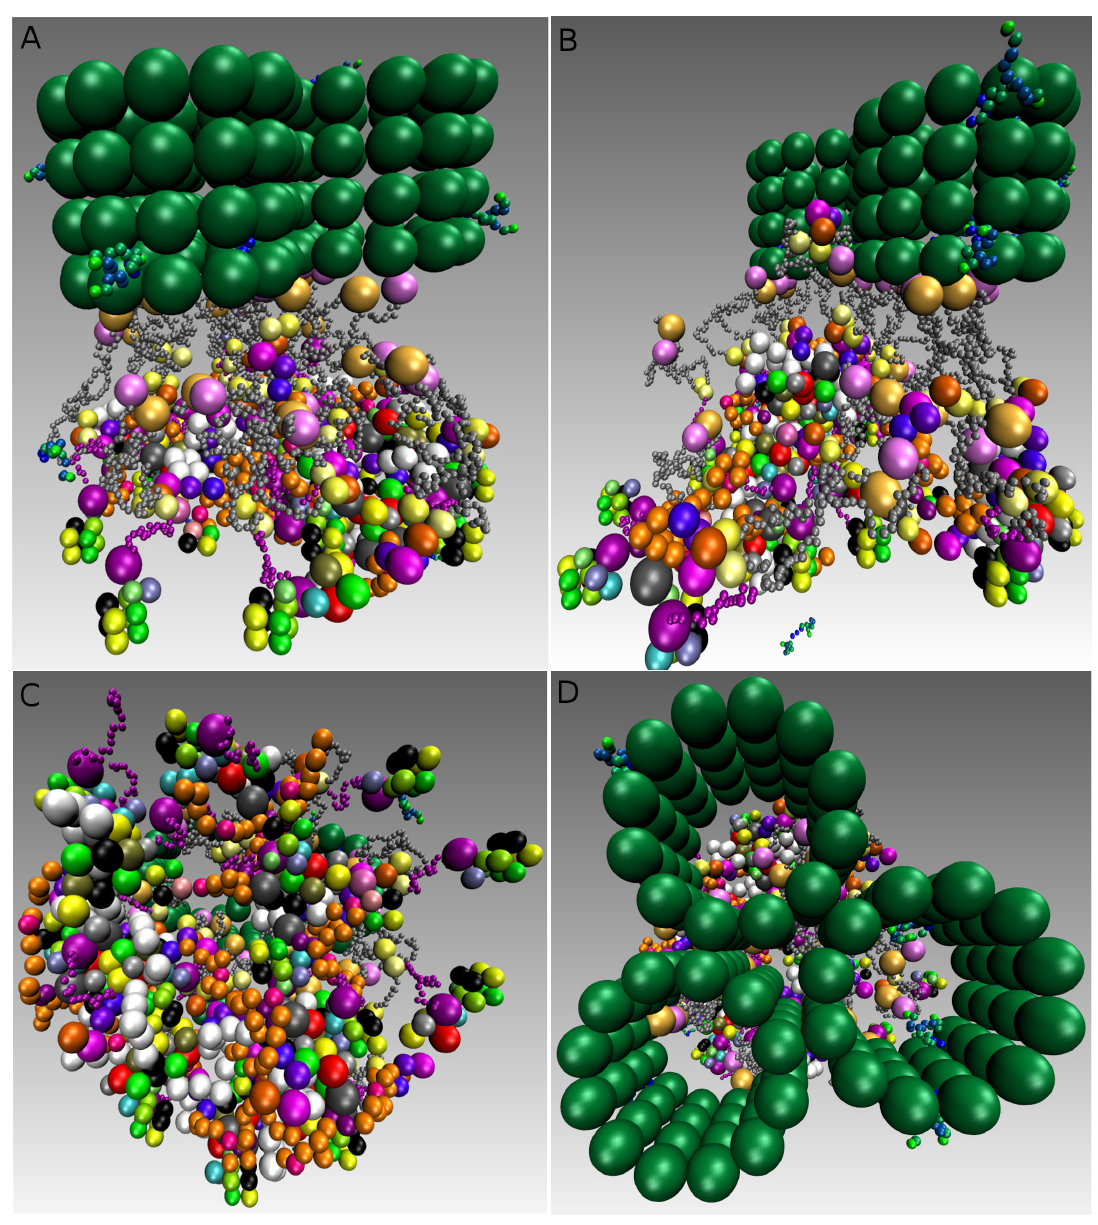
Figure 12. Multiple rosette-like structures assembly in mitosis. ( A ) Shows three rosette-like structures attached to three microtubules; ( B ) Same as in ( A ), where only two microtubules are present and attached with many cross-links occurring; ( C ) Shows that the assembly of the well-defined rosette-structures cannot be obtained for the multiple microtubules attached ( A ); ( D ) Top view of the simulation process shows the arrangement of the microtubules in ( A ). Simulations with multiple microtubules took about three